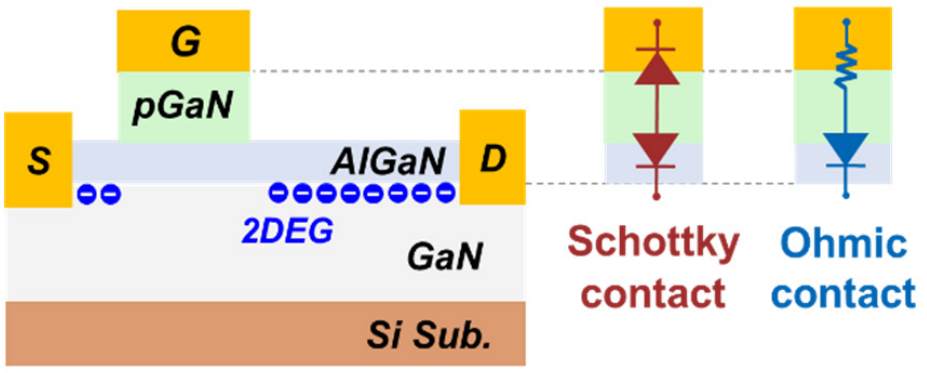
Figure 1. Schematics of the GaN HEMT device and gate structures. Pulsed transfer characteristic tests with prolonged negative quiescent gate bias ( V GSQ ) were carried out under a Keithley 4200-SCS system with ultrafast I-V modules (4225-PMU).